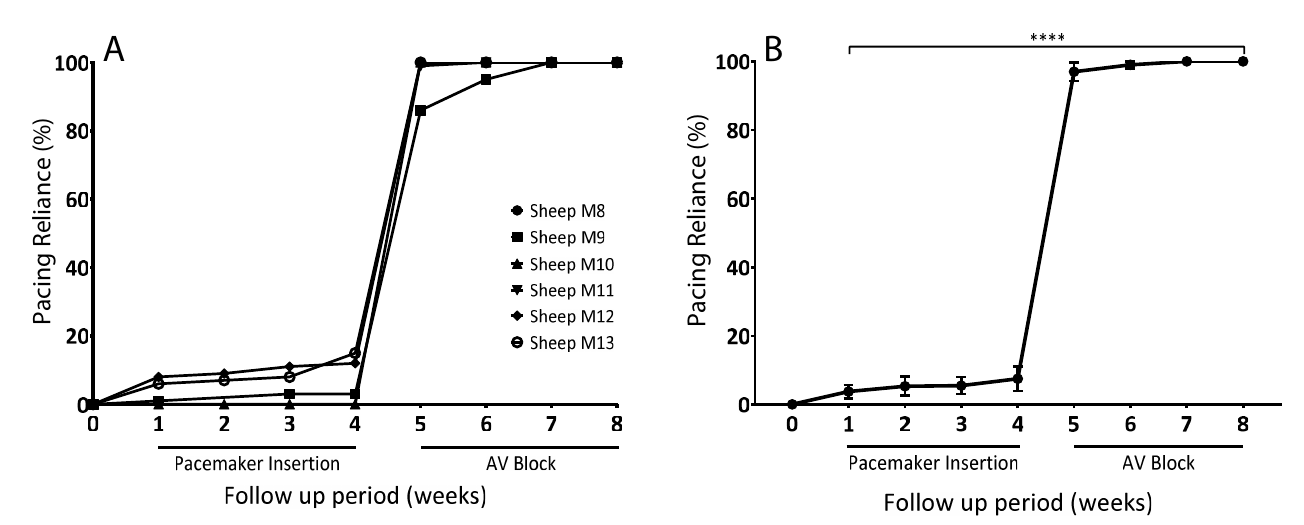
Fig 10. Diagnostic pacing data collected from pacemakers during baseline and post-ablation periods. (A) Pacing reliance was collected for 4 weeks following pacemaker implantation. His bundle ablation was performed at the week 4 timepoint, after which pacing reliance was collected for a further 4 weeks (B) Mean pacing reliance trends presented over the total examined period (% pacing reliance). Data is presented as mean ± SEM. N = 5. Statistically significant if p < 0.05.